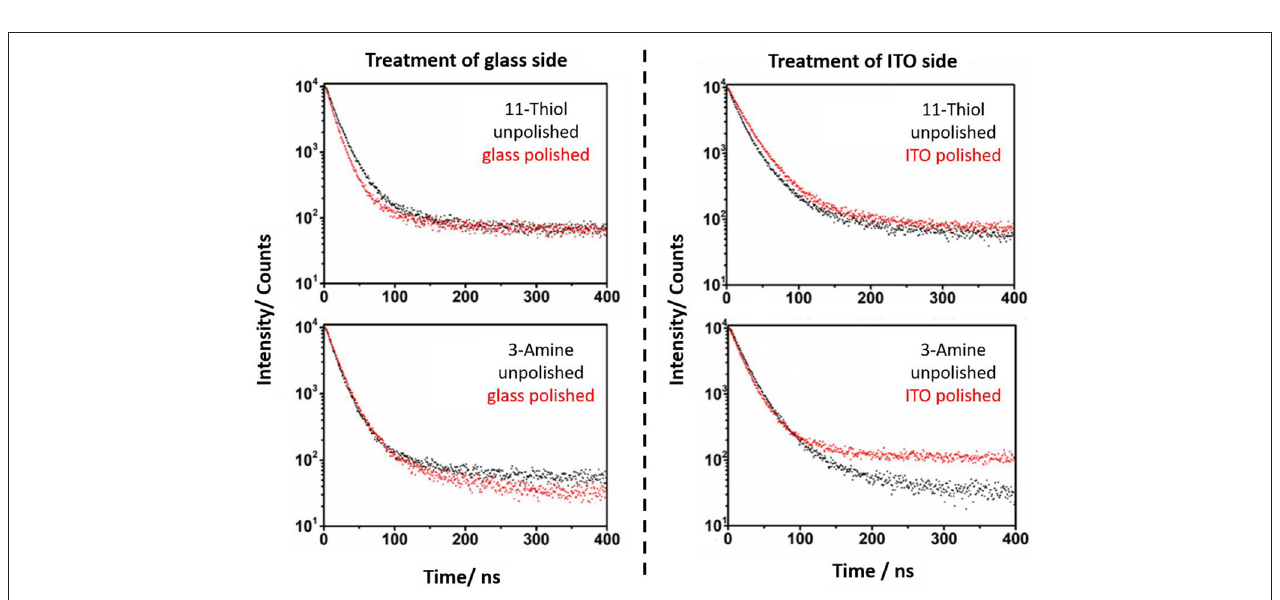
FIGURE 7 | The PL lifetime of NR, which are linked to substrates via 11-thiol and 3-amine, is measured. The spectra of unpolished (black) and polished (red) slides is shown. The lifetimes of unpolished and polished slides vary strongly in case of 11-thiol but not in their 3-amine counterparts.